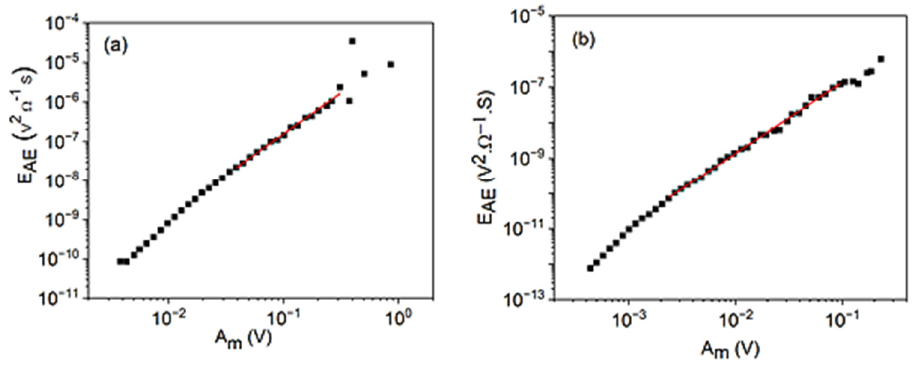
Figure 7. logE AE versus logA m plots for cooling in alloy A ( a ) at small, constant, external magnetic field (B = 250 mT) and for heating in alloy B ( b ) (at B = 0).